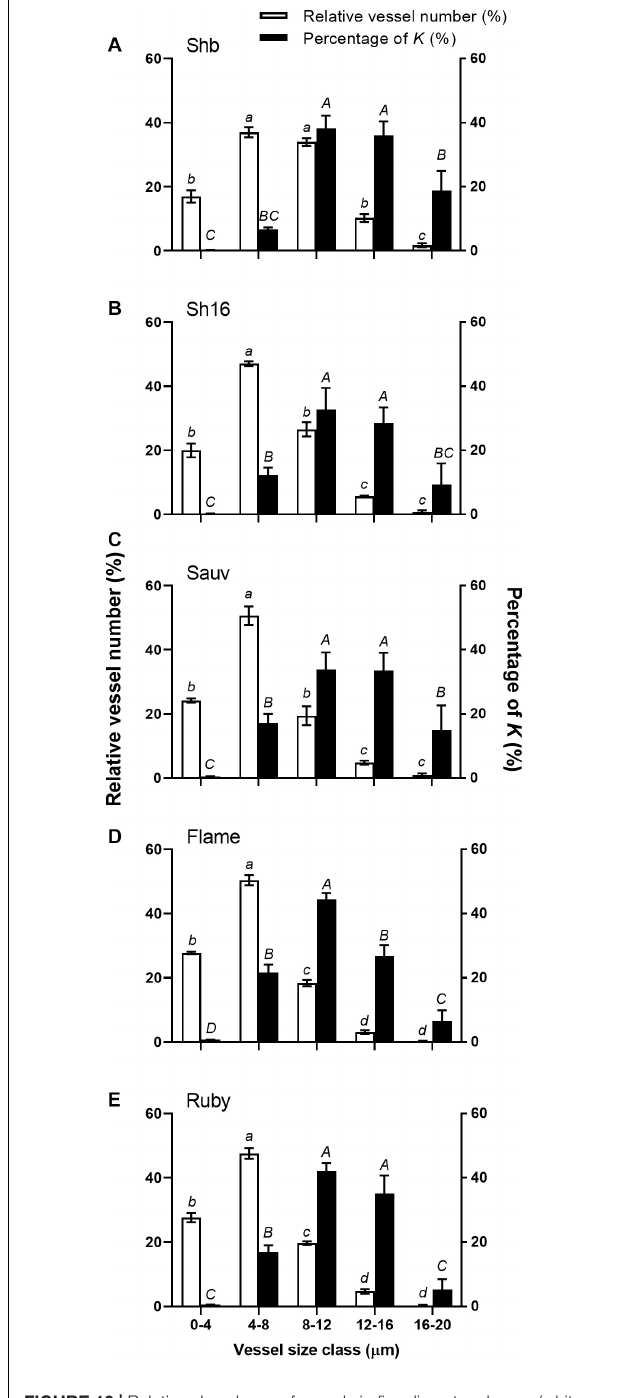
FIGURE 10 | Relative abundance of vessels in five diameter classes (white bars) and their relative contribution to the potential area-specific hydraulic conductivity ( K , in percent, black bars) in the receptacle of Shiraz BVRC12 (A) , Shiraz 1654 (B) , Sauvignon Blanc (C) , Flame Seedless (D) , and Ruby Seedless (E) . Data are presented as mean ± s.e.m. ( n = 3 or 4). Where lower-case letters are shown, it indicates differences between diameter classes in the abundance of vessels and where upper-case letters are shown, it indicates differences between the relative contributions to K (Fisher’s LSD test, P <